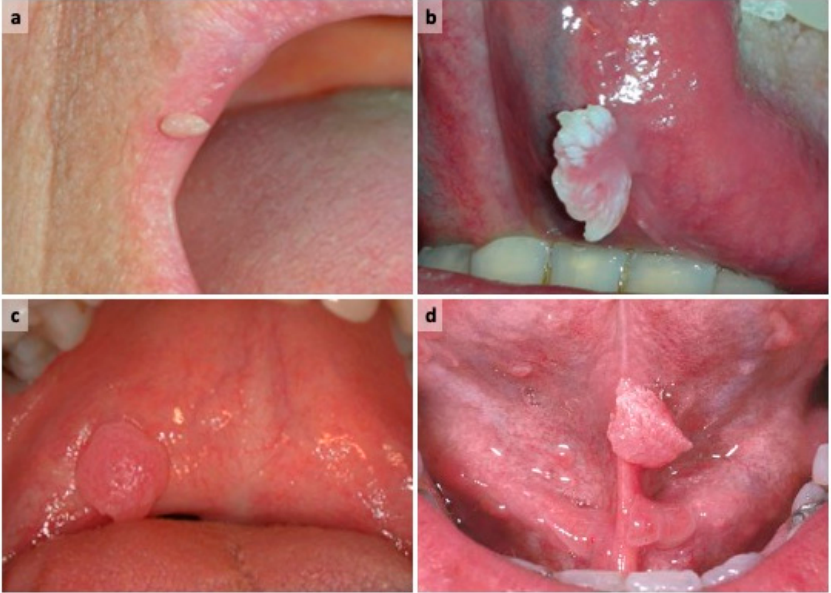
Figure 1. Oral lesions traditionally associated with LR-HPV: ( a ) wart on upper lips; ( b ) papilloma on ventral surface of tongue; ( c ) condyloma on soft palate; ( d ) condyloma on ventral surface of tongue.